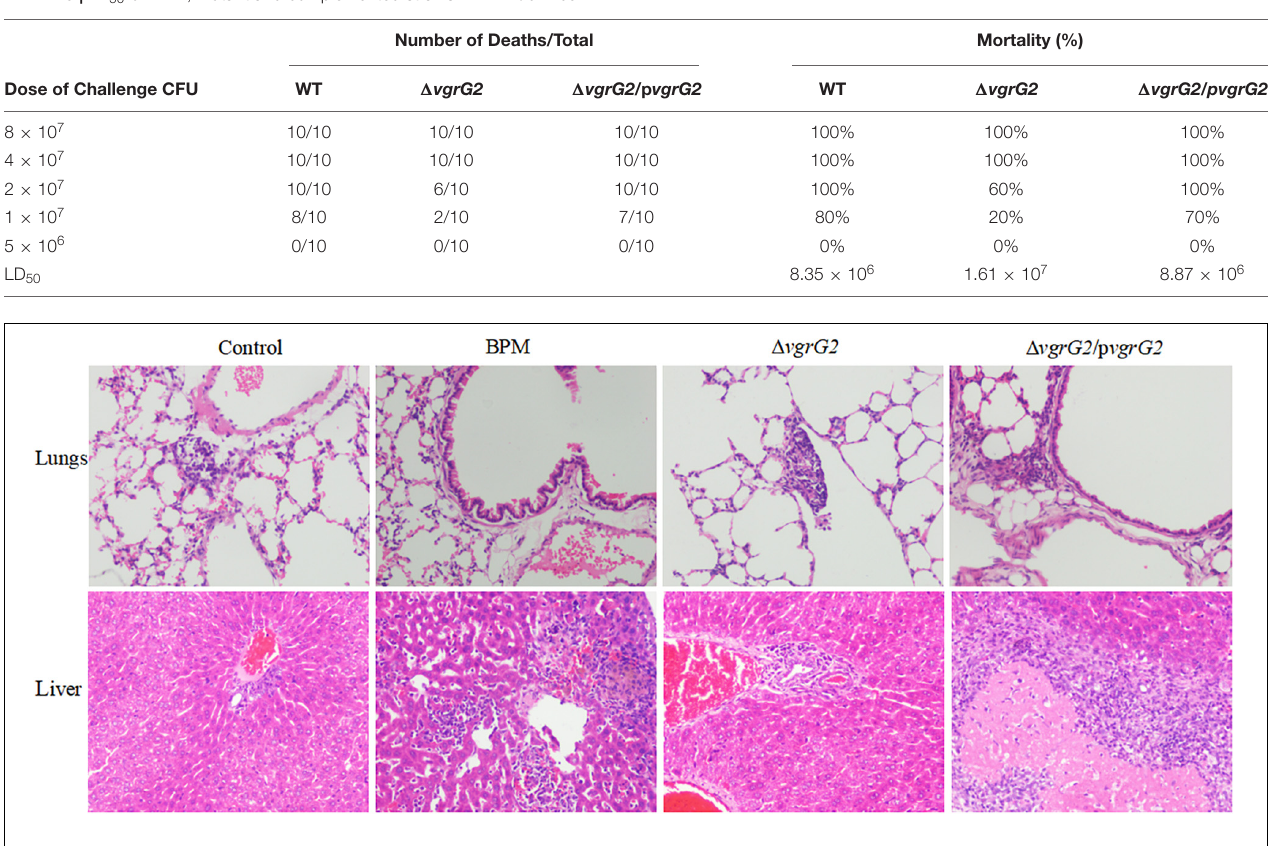
No growth rate difference was found when the mutant and complemented strains were compared with BPM ( Supplementary Figure 2 ). The antimicrobial susceptibility